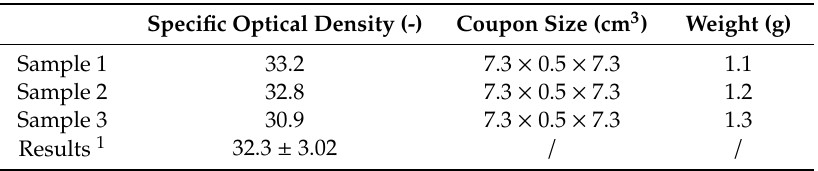
Table 3. Smoke Test for Cabin Materials FAR